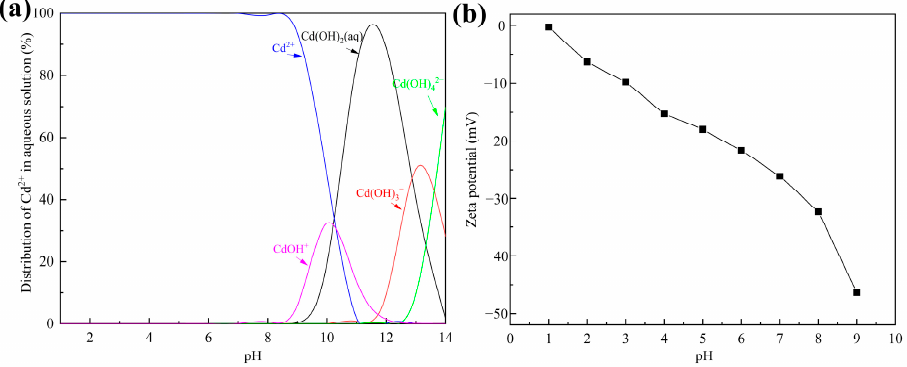
Figure 5. ( a ) The distribution of Cd 2+ in aqueous solution simulated with Visual MINTEQ 3.1; ( b ) zeta potential of tobermorite at different initial solution pH values.